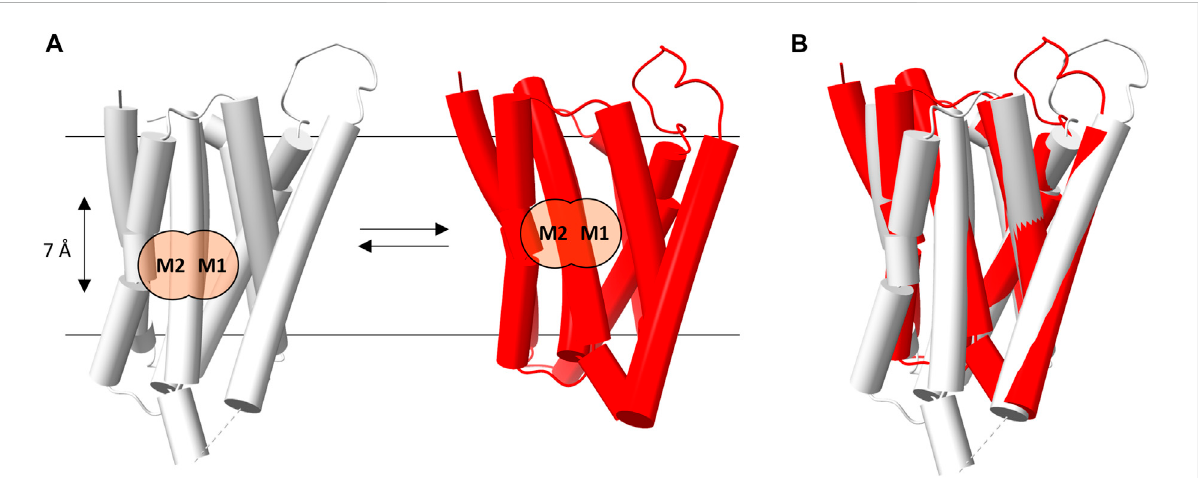
FIGURE 2 hZIP4 conformational transition. (A) Schematic representation of the transition between the inward- (gray) and outward- (red) facing conformations of hZIP4. The M2 and M1 binding sites are marked with black labels and two orange circles, in order two better show the relative position (7 Å apart) of the bimetal cluster in each conformational state. (B) Superimposition of the two hZIP4 conformations.